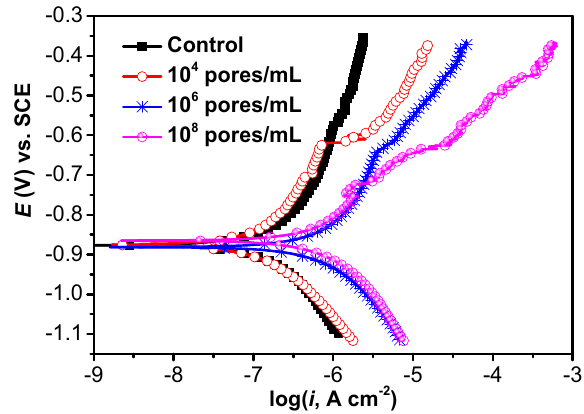
Fig. 6 Potentiodynamic polarization curves. Showing results for AA specimens corresponding to different initial spore concentra- tions of A. terreus with continued organic carbon